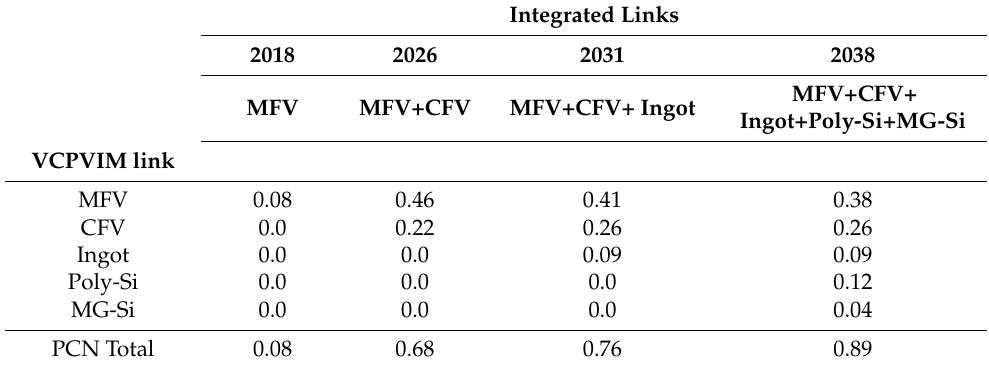
Table 13. Proportion of national content of each link of the VCPVIM in the Alternative